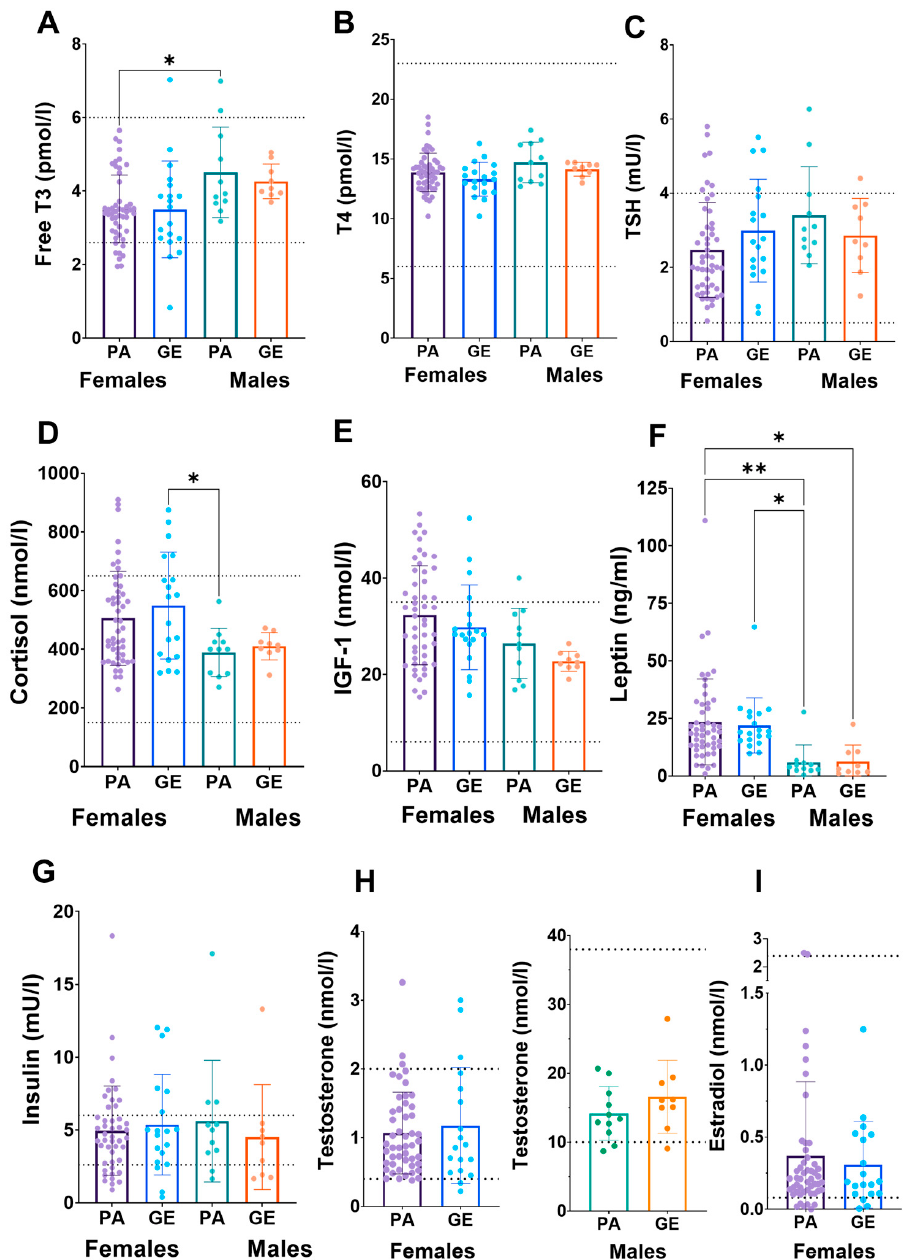
Figure 2. Serum hormone concentrations ( A – I ) in physique athletes (PA) and gym enthusiasts (GE). 2 × 2 ANOVA (main and interaction effects) p -values are shown as text above the bars and possible post hoc (Tukey’s test) differences in mean values between individual groups. * = p < 0.05 and ** = p < 0.01. Dashed lines indicate national reference ranges except for leptin, of which reference values are BMI- and sex-dependent and thus not shown. The data were complete ( n = 89), except for TSH ( n = 88), insulin ( n = 85), testosterone ( n = 87) and estradiol ( n = 88). Long-term LEA can lead to low bone mineral density (BMD) [20]. Bone mineral density was similar in female and male physique athletes when compared to gym enthusiasts (Figure 3A), while in males, the BMD (1.33 ± 0.08 g/cm 2 ) was higher than in